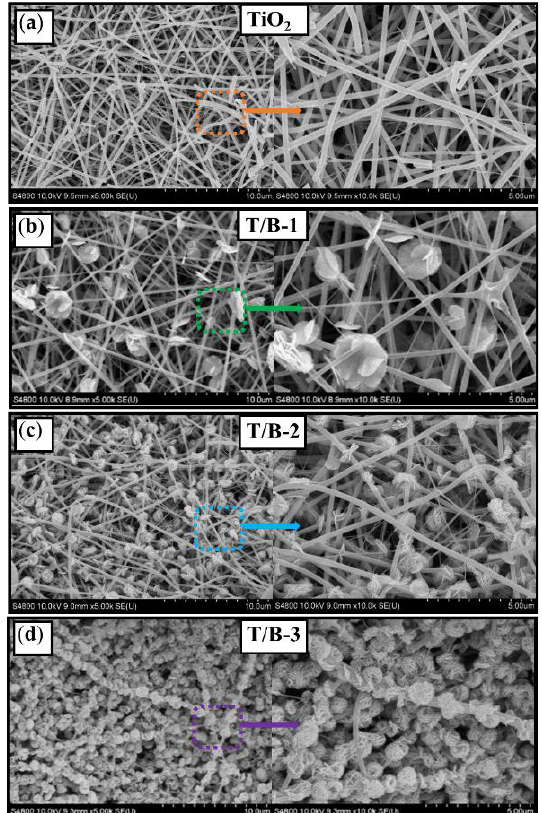
Figure 2. SEM images of ( a ) TiO 2 fibers and local magnification, ( b ) T/B-1 fibers and local magnification, ( c ) T/B-2 fibers and local magnification, ( d ) T/B-3 fibers and local magnification.